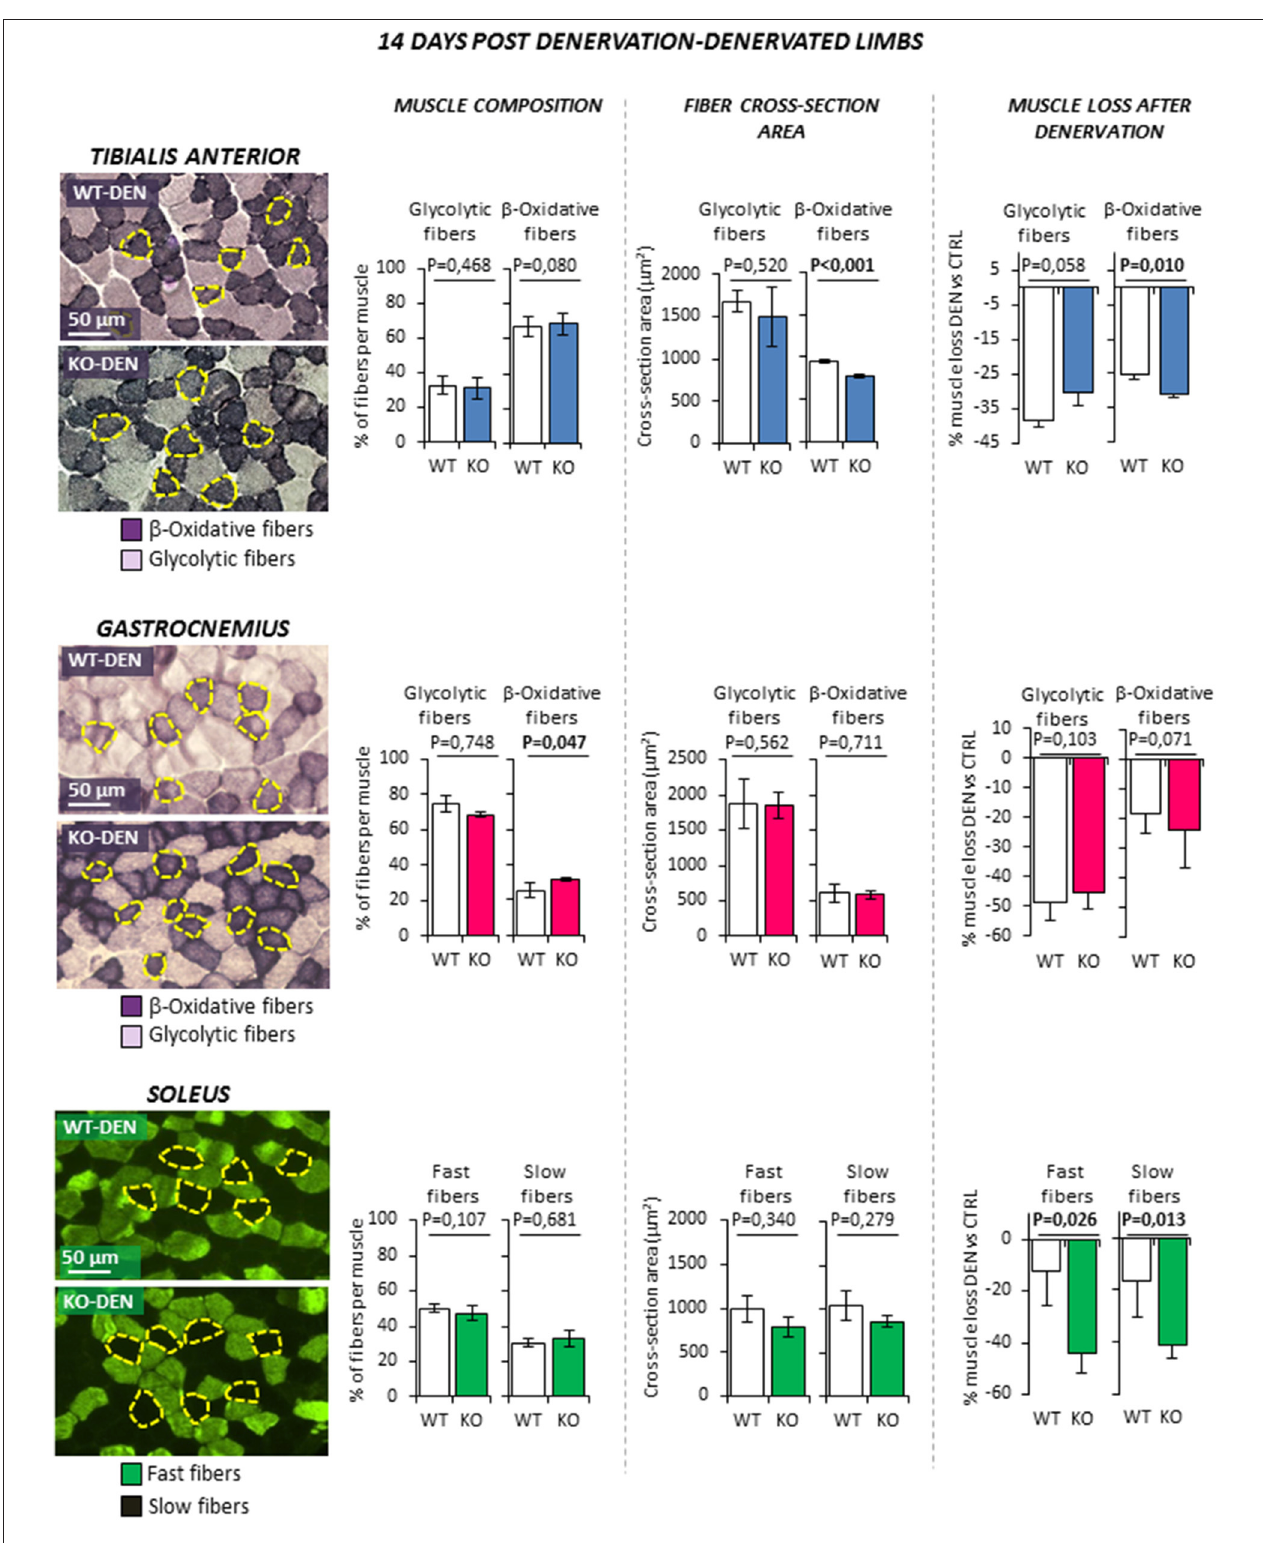
FIGURE 4 | Effect of leg denervation on fiber composition and cross section area in tibialis anterior , gastrocnemius and soleus muscles in wild type (WT, N = 6) and Rxfp2 − / − mice (KO, N = 5). Results obtained in denervated limbs (DEN) are given after 14 days from denervation. Data in tibialis anterior , gastrocnemius muscle